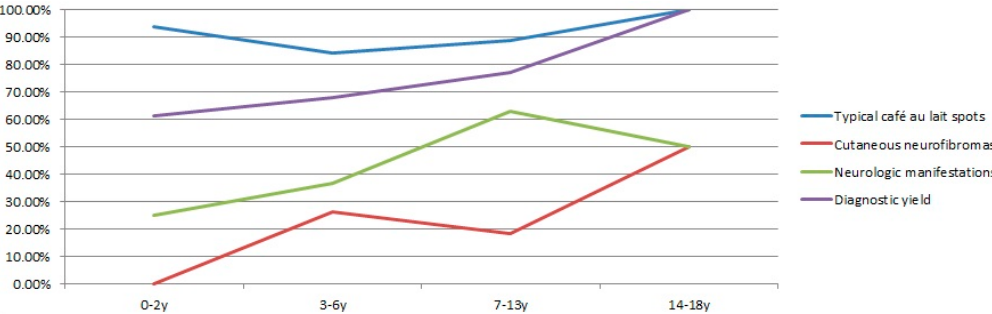
Figure 1. Correlations of the clinical expression and diagnostic yield for four age groups (infants